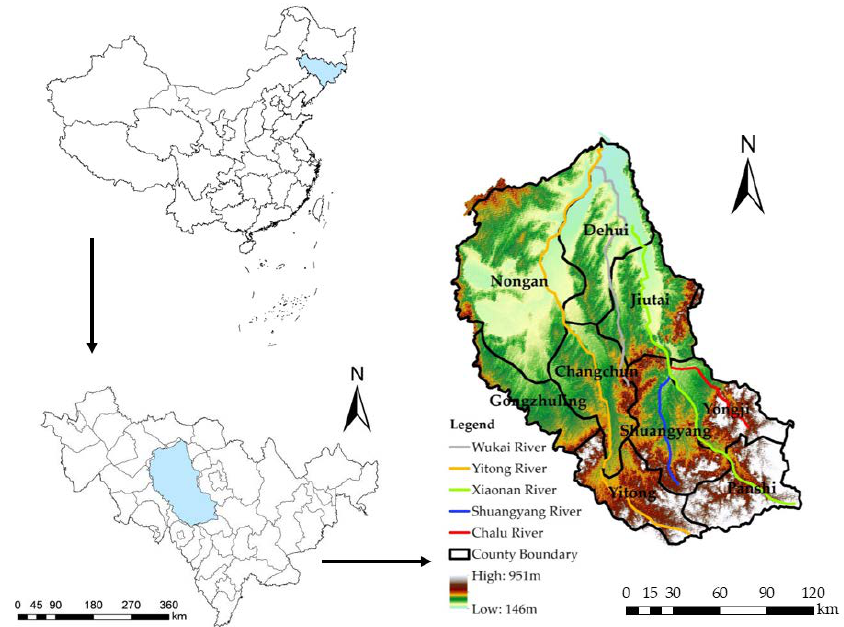
Figure 1. Location of the Yinma River Basin, China.